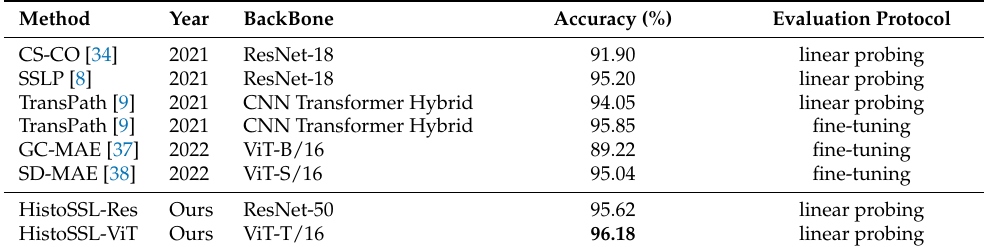
Table 7. Comparing our proposed method with recent self-supervised learning studies on the NCTCRC dataset. The results are directly quoted from the corresponding